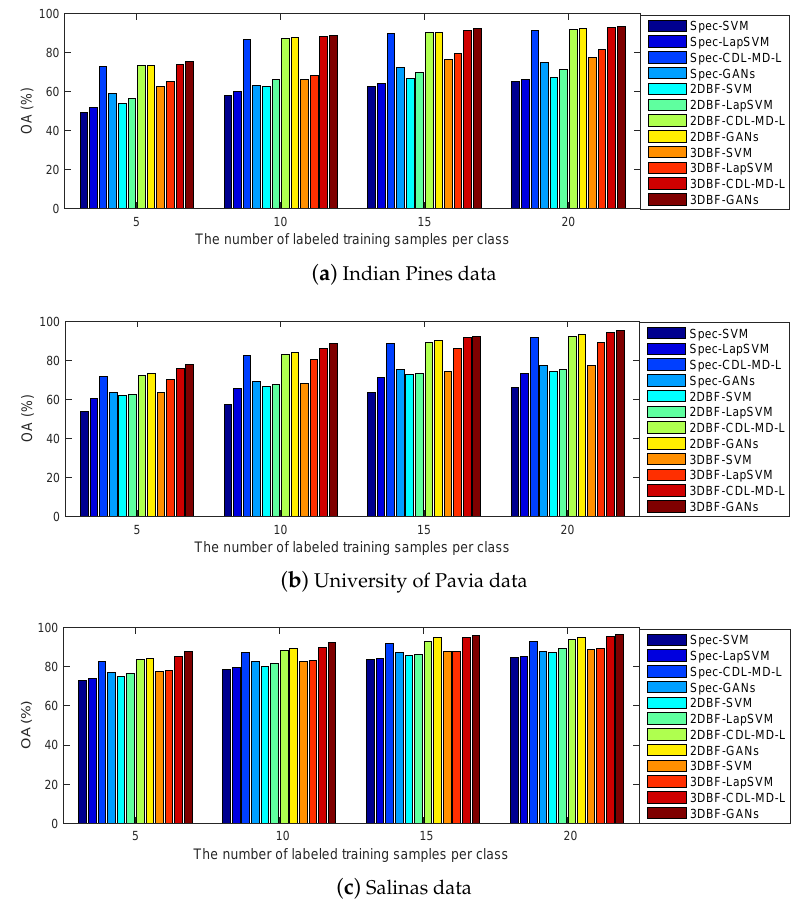
Figure 17. The impact of the number of labeled training samples per class on the OA in ( a ) Indian Pines data, ( b ) University of Pavia data and ( c ) Salinas